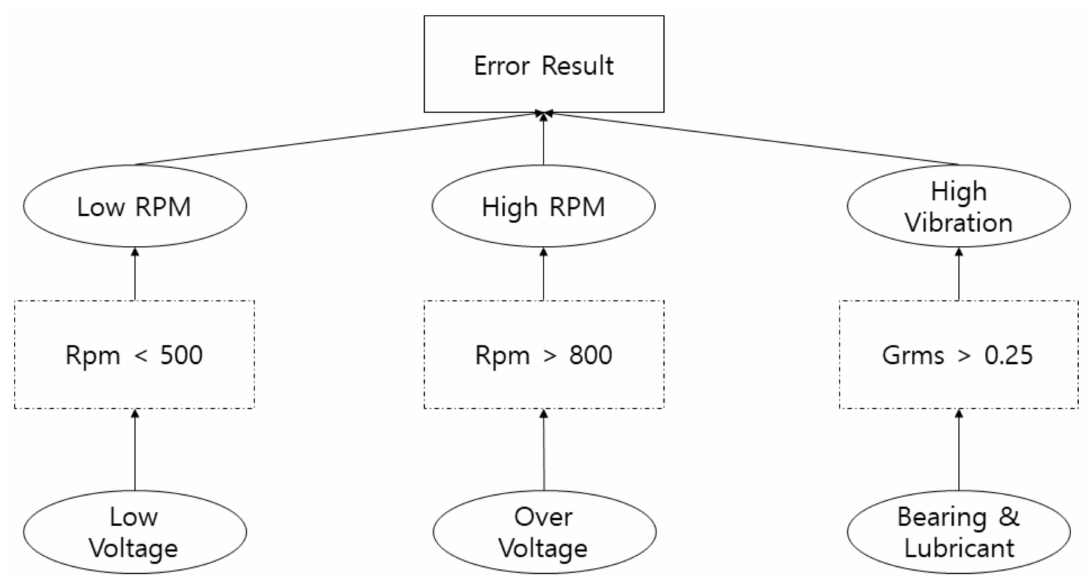
Figure 14. Example error